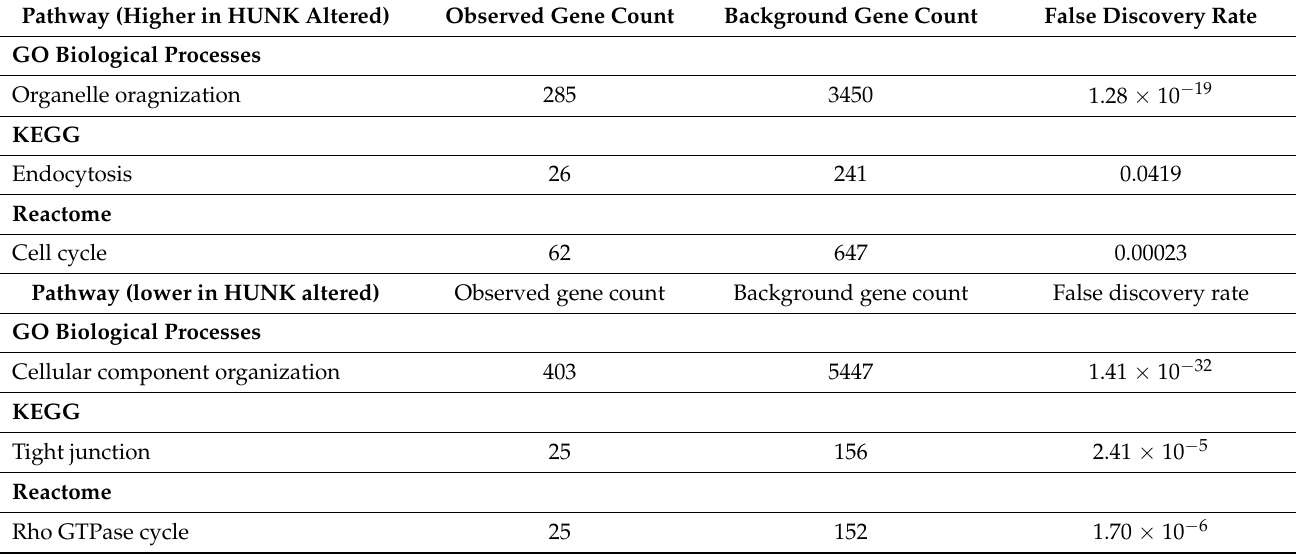
Table 3. Phospho-proteome analysis: Factors that were over-represented in the HUNK altered group assessed using GO Biological Processes, KEGG, and Reactome databases that were consolidated by the STRING